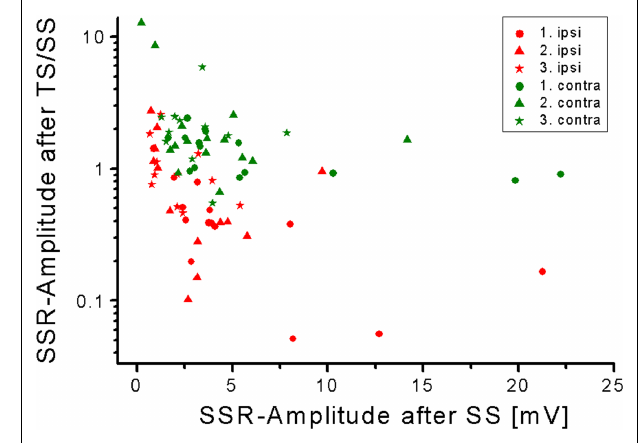
FIGURE 3 | Negative relation of SSR amplitudes measured afterTS/SS compared with SS. Note the higher SSR-amplitude-gain contralateral obtained after train stimuli in comparison to single